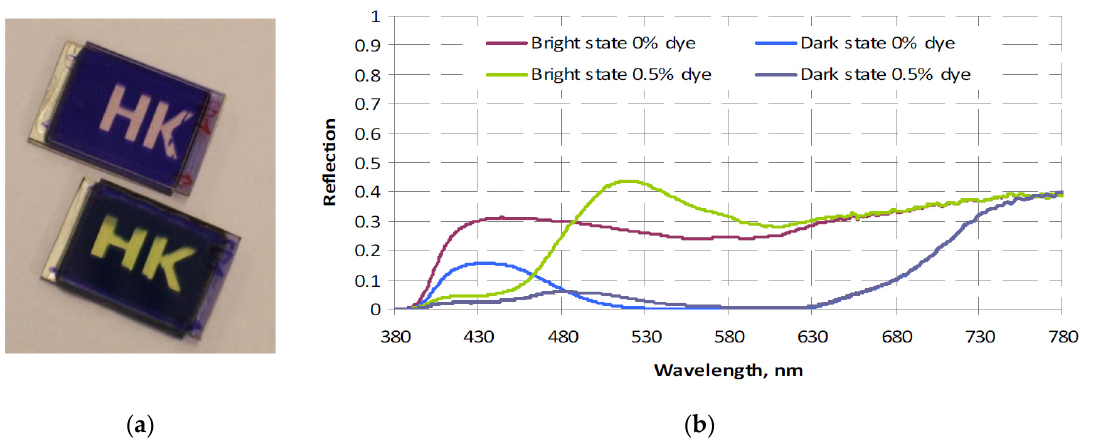
Figure 4. (Color online) ORW e-paper: ( a ) regular ( top ) and with improved dark state ( bottom ); ( b ) reflection spectra of dark and bright states for 0% and 0.5% dyes.